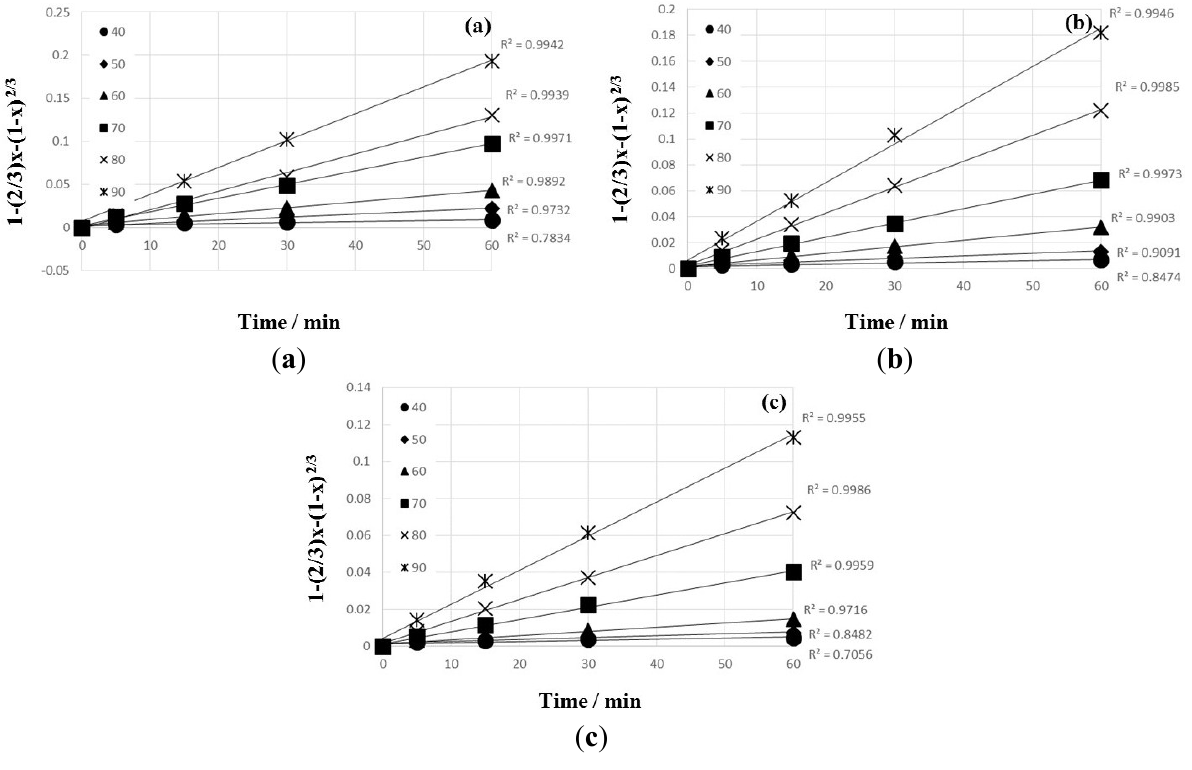
Figure 6. Plot of 1 − 2/3 x − (1 − x ) 2/3 vs. T for different temperatures ([Fe 3+ ]: ( a ) 1.0 M; ( b ) 0.5 M; ( c ) 0.25 M; 10% pulp density; 400 rpm agitation